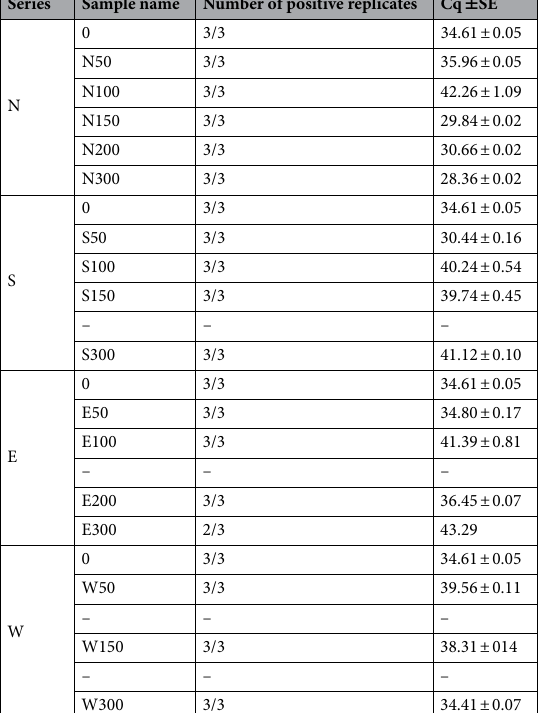
Table 5. Real-time PCR results for Port Island November 2018. Sample 0 in each series was collected beside the reference nest and was common to all series. The letters represent their series for all other sample names, and the numbers represent the distance from the nest (cm). The column “Cq” represents the average of the Cq values among three PCR replicates (the average of the two positive replicates for E300). Samples from S200, E150, W100, and W200 were excluded because DNA could not be extracted successfully (see text for details). The raw data are listed in Table